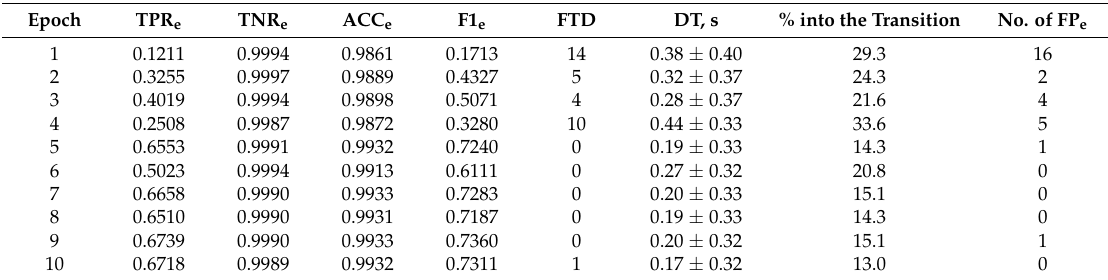
Table 4. Evaluation of the ELM model.